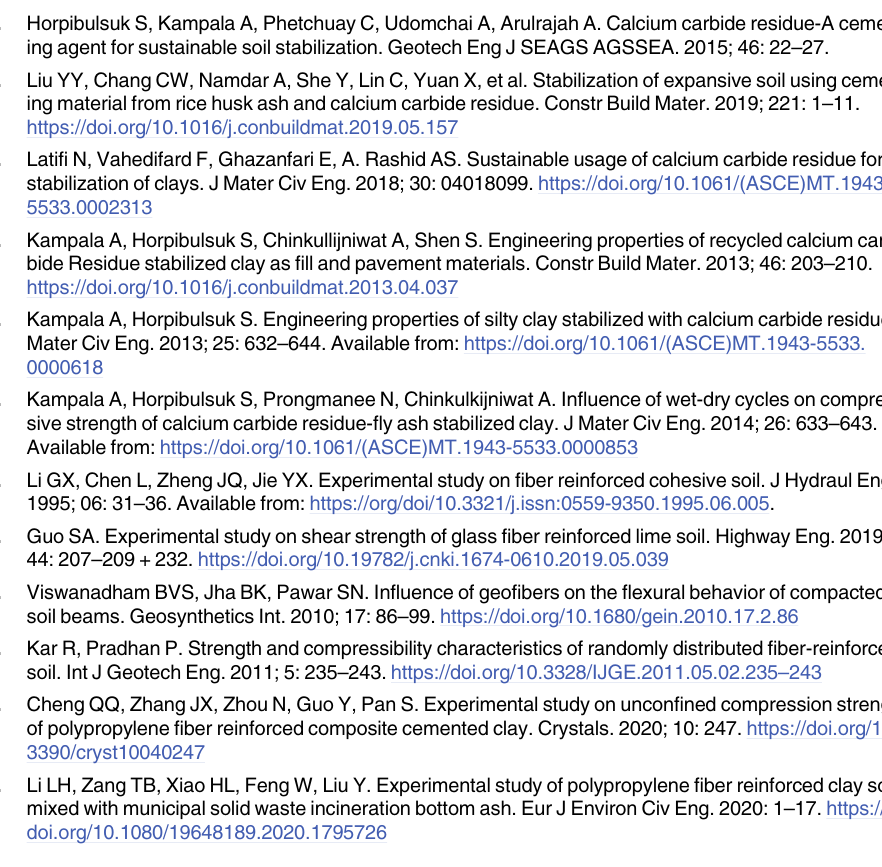
S1 Table. Results of compaction test. S2 Table. Results of unconfined compression strength test. S3 Table. Results of indirect tensile strength